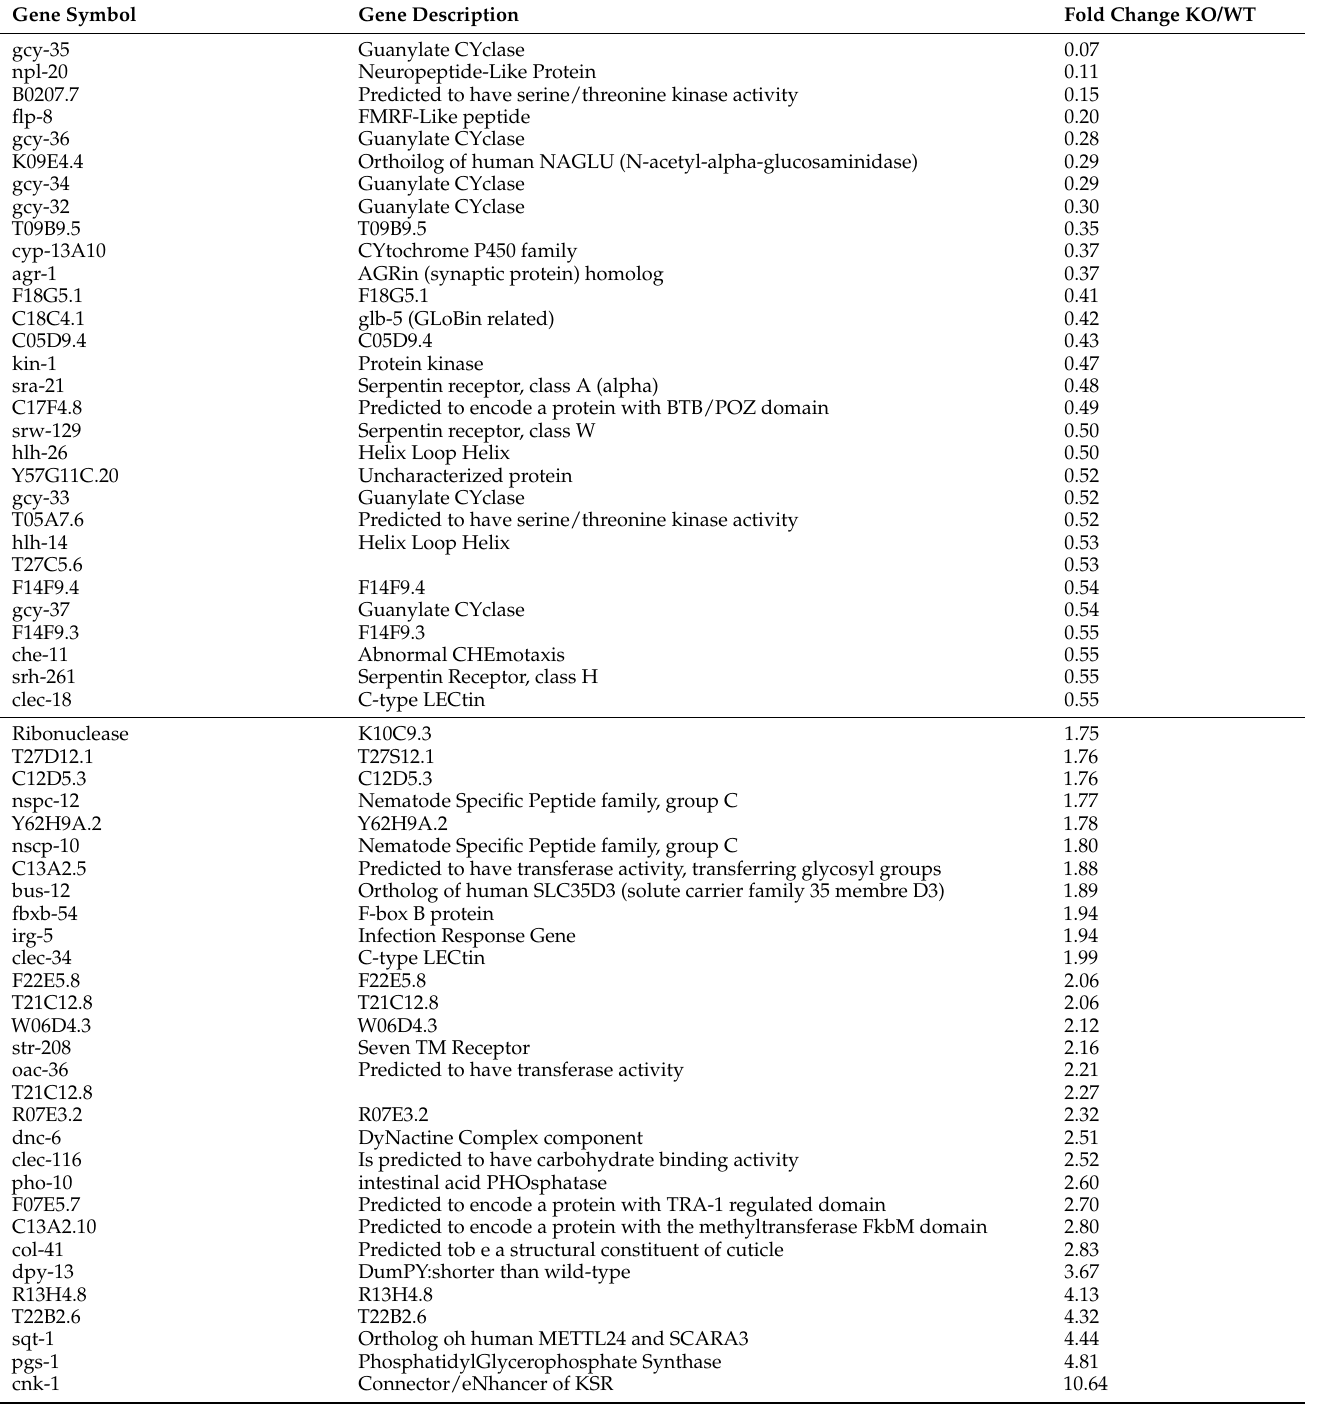
Table 1. Gene expression profile in ahr-1 mutants vs. wild-type animals. Top list of down-regulated and up-regulated genes in ahr-1 mutant vs. WT C. elegans